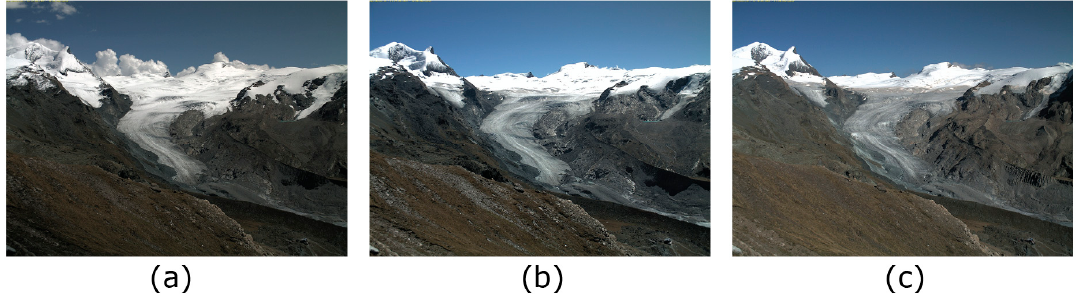
Figure A1. In situ camera images of Findelengletscher on 22 ( a ), 29 ( b ) and 30 ( c ) August 2015. The recession of the snowline between 22 and 30 August is clearly visible. (Image courtesy of ACAG, Unifr).